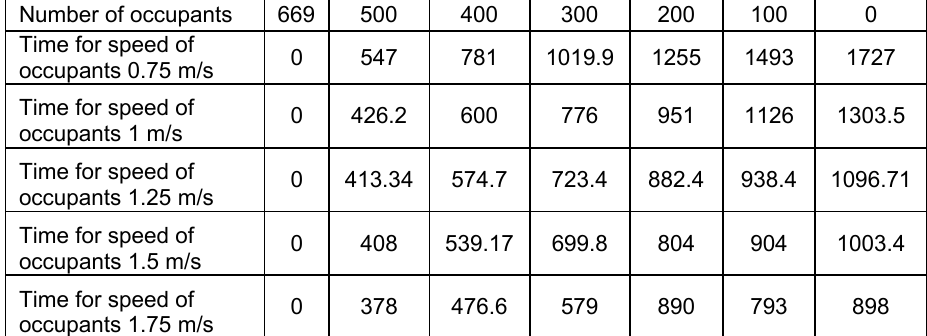
Table 29 – Simulation results in seconds for the fourth scenario, with elevators disabled and the third entrance/exit opened, while the first, the second and the fourth entrances/exits are blocked, and for the occupants’ speeds from 0.75 m/s, 1 m/s, 1.25 m/s, 1.5 m/s, and 1.75